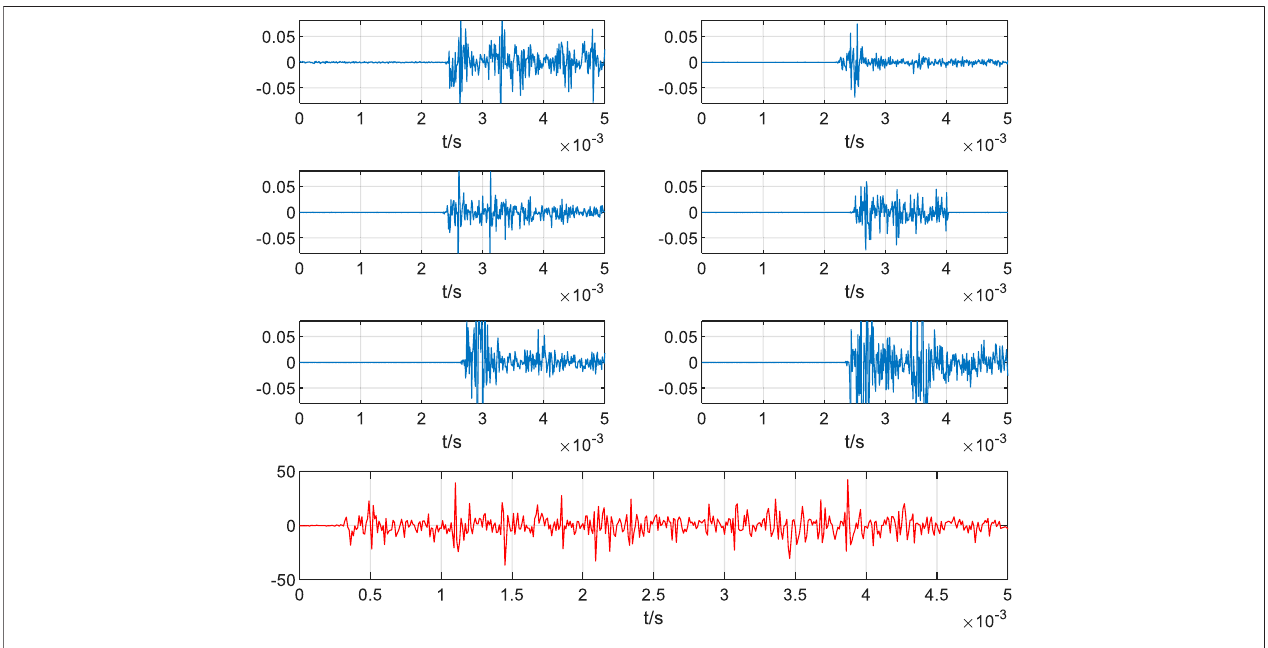
FIGURE 6 | The ultrasonic localization result using TWCP-0.5/50 transformer testbed